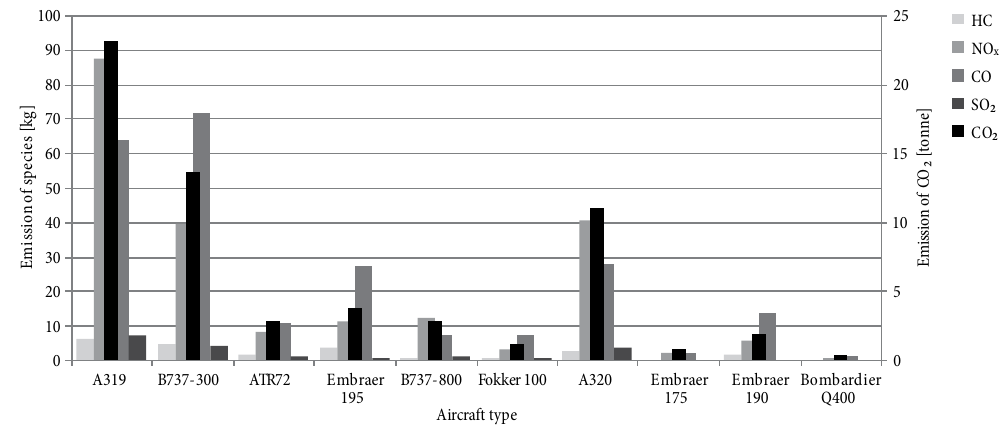
Fig. 4. Distribution of the LTO emissions factors by aircraft